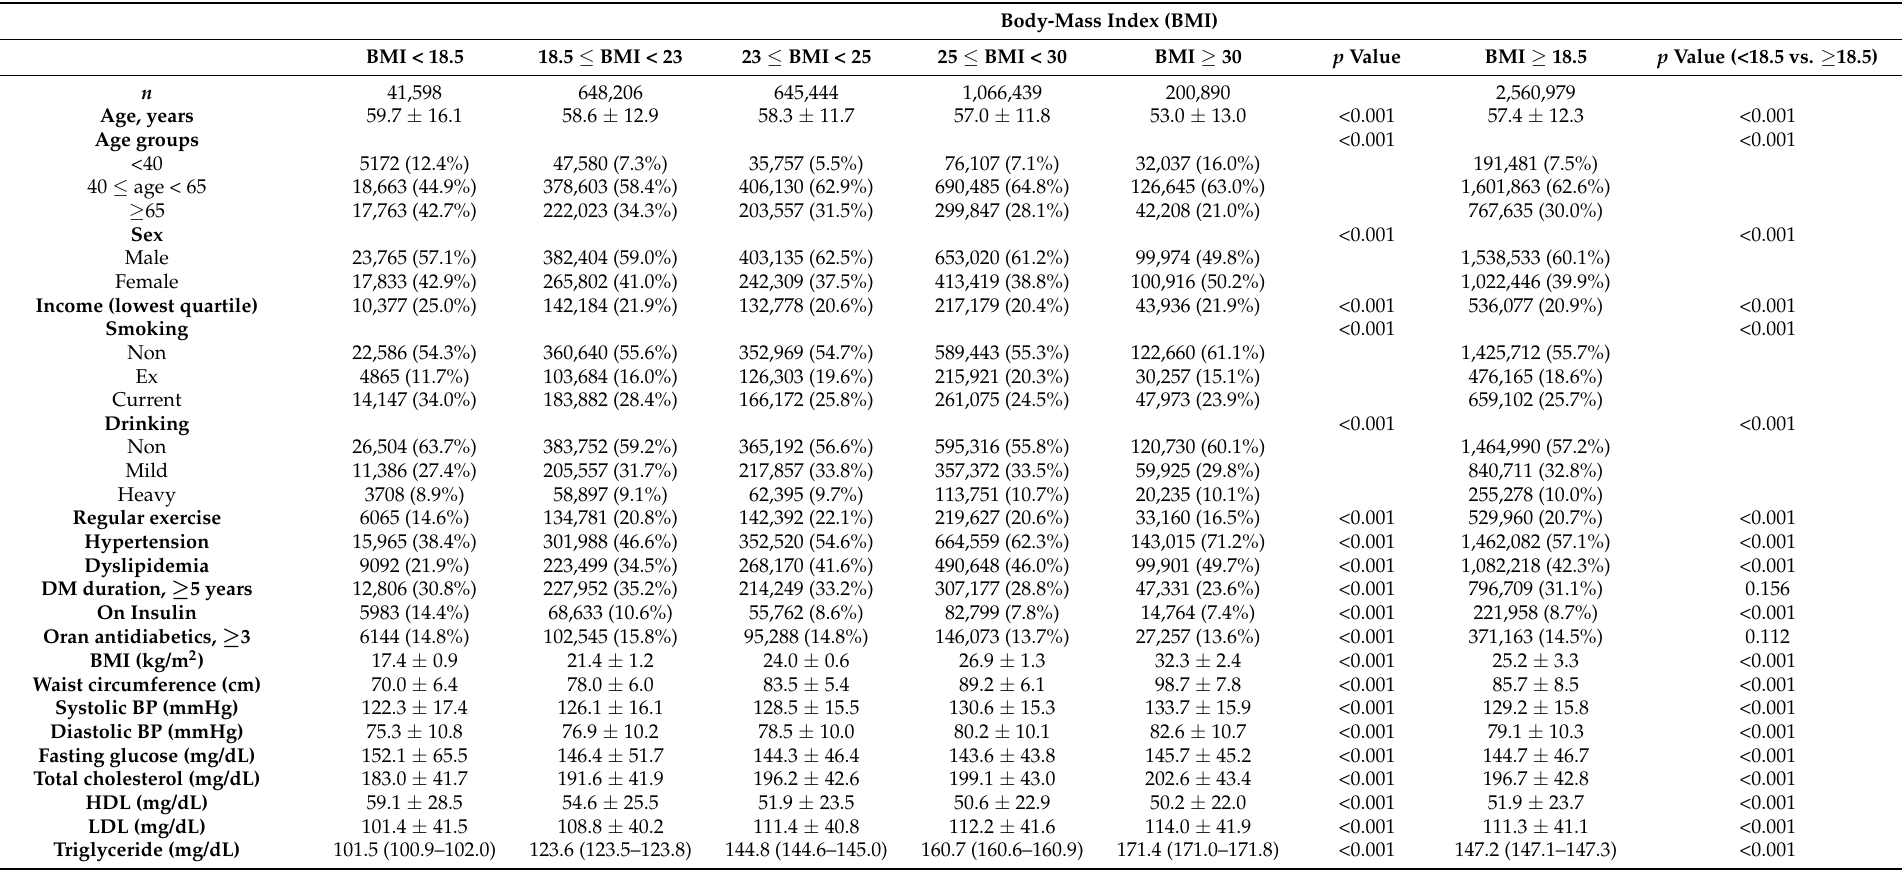
Table 1. Baseline characteristics of people according to BMI